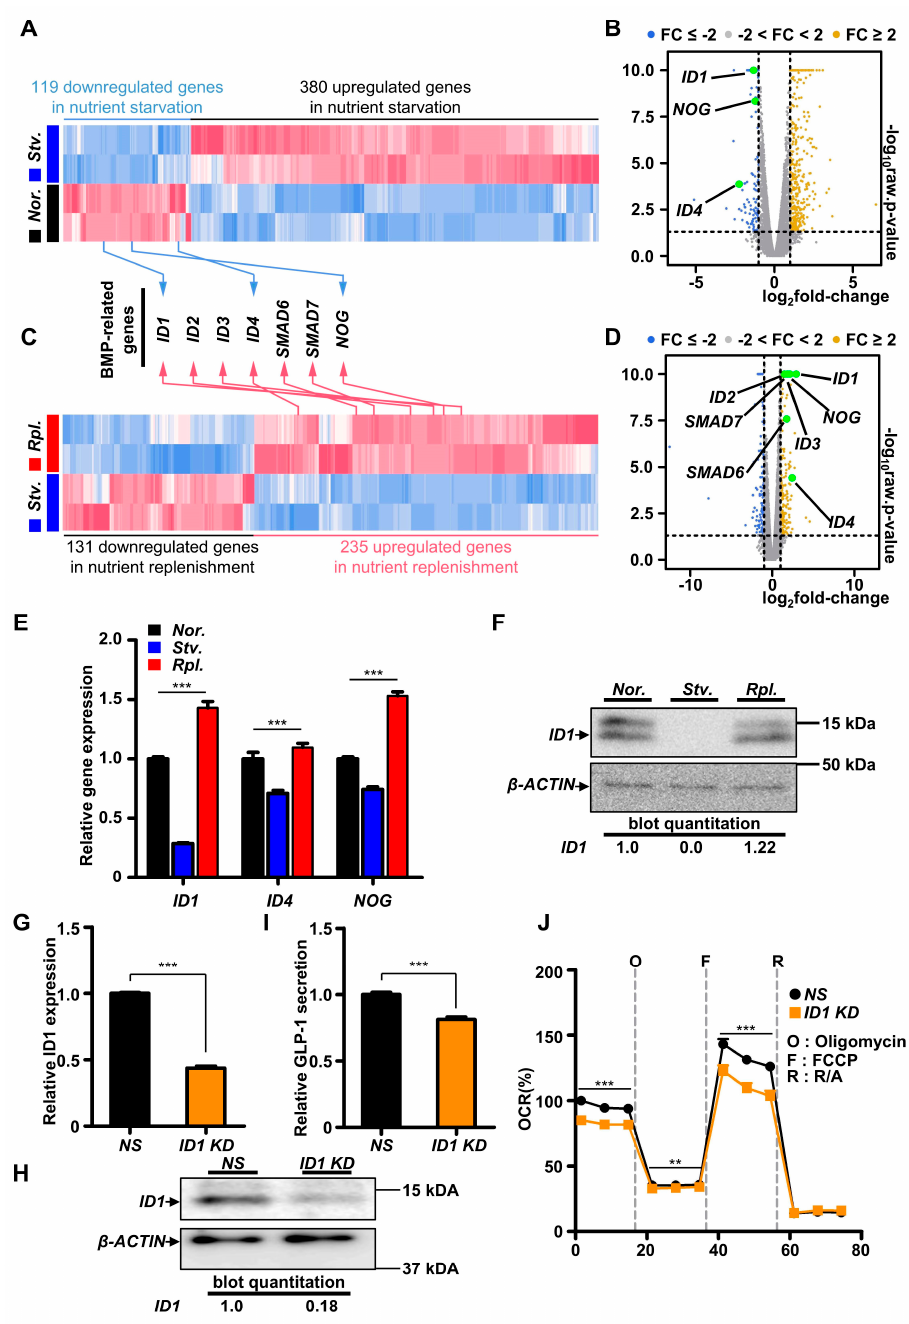
Figure 3. Inhibitor of DNA binding (ID)1-mediated BMP signaling modulated GLP-1 secretion in GLUTag cells. ( A ) Heatmap for normal versus starvation gene expression profile with overlapped BMP-related hub genes from protein association network. ( B ) Volcano plot of normal versus starvation gene expression profiles. ( C ) Heatmap for starvation versus replenishment gene expression profile with overlapped BMP-related hub genes from protein association network. ( D ) Volcano plot of starvation versus replenishment gene expression profiles. ( E ) mRNA expression level of ID1, ID4, and NOG according to nutrient status ( n = 4 − 7). ( F ) ID1 protein level according to nutrient status. ( G ) mRNA level of ID1 gene with siRNA ( n = 4) (NS; non-specific siRNA; KD; knockdown with targeted siRNA). ( H ) Protein level of ID1 with siRNA. ( I ) Basal GLP-1 secretion in GLUTag cells with ID1 siRNA ( n = 12). ( J ) Cellular bioenergetics of GLUTag cells with ID1 siRNA ( n = 6). Data represent the mean ± SEM. ** p < 0.01; *** p < 0.001; one-way ANOVA was performed for (E) and (J). Student’s t -test was performed for (G) and (I).